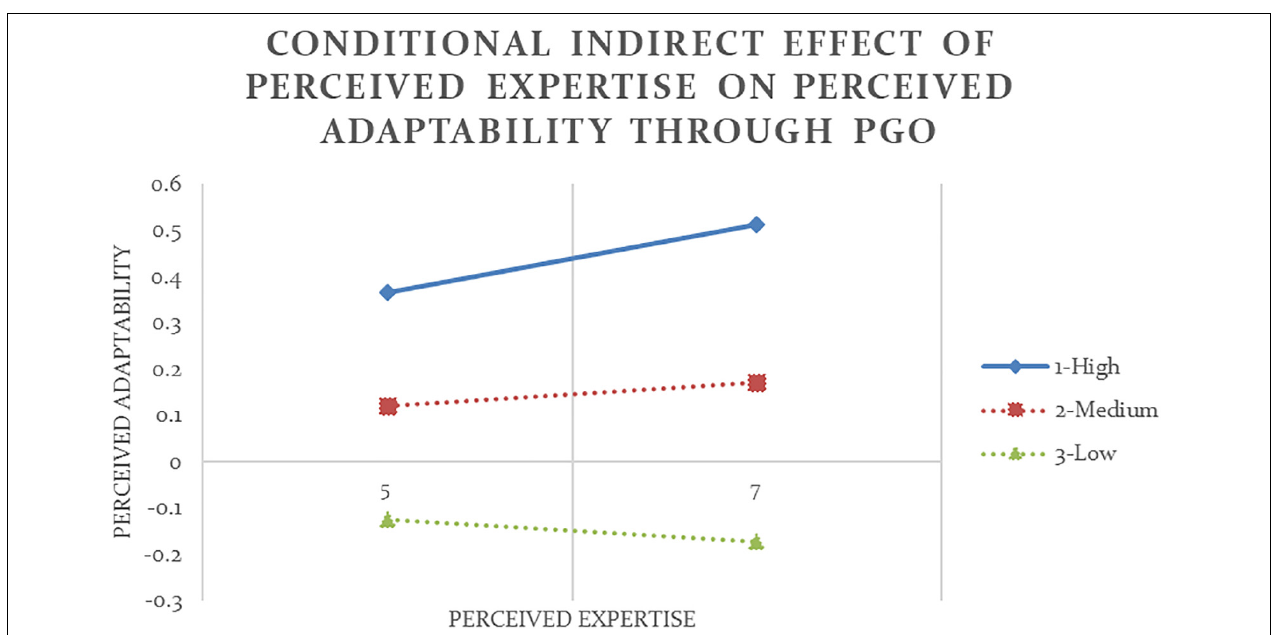
FIGURE 5 | Conditional indirect effect of other-report expertise on other-report adaptability through PGO is significant at high values of the moderator self-report humility with 90% confidence (Analysis #12).